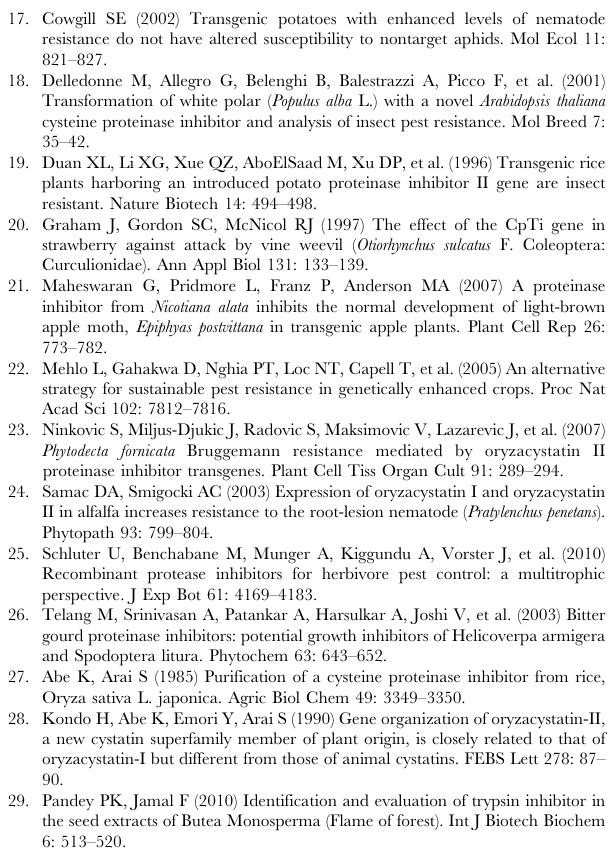
Values represent mean larval weight 6 SE (mg). Means followed by the same superscript within columns are not significantly different ( P , 0.05) by one-way ANOVA test. { Larvae started to pupate at 9 days; Number in parenthesis indicates the number of living larvae out of 10 at start of experiment.